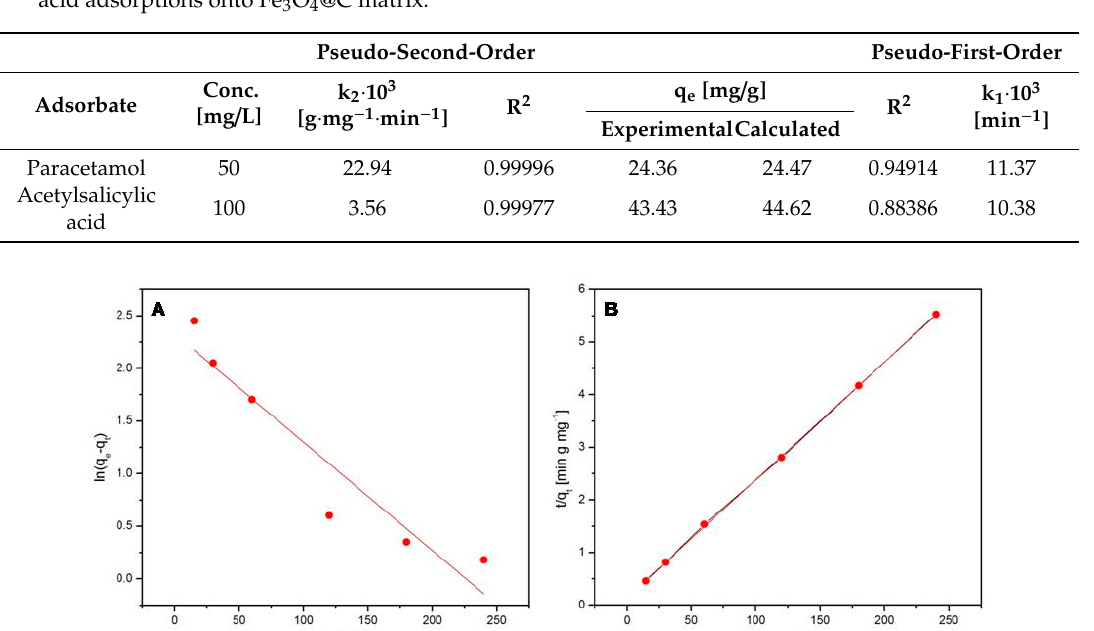
Figure 9. The pseudo-first-order ( A ) and the pseudo-second-order ( B ) models for paracetamol adsorption. Table 2. Kinetics parameters and the correlation coe ffi cients (R 2 ) for the paracetamol and acetylsalicylic acid adsorptions onto Fe 3 O 4 @C matrix.